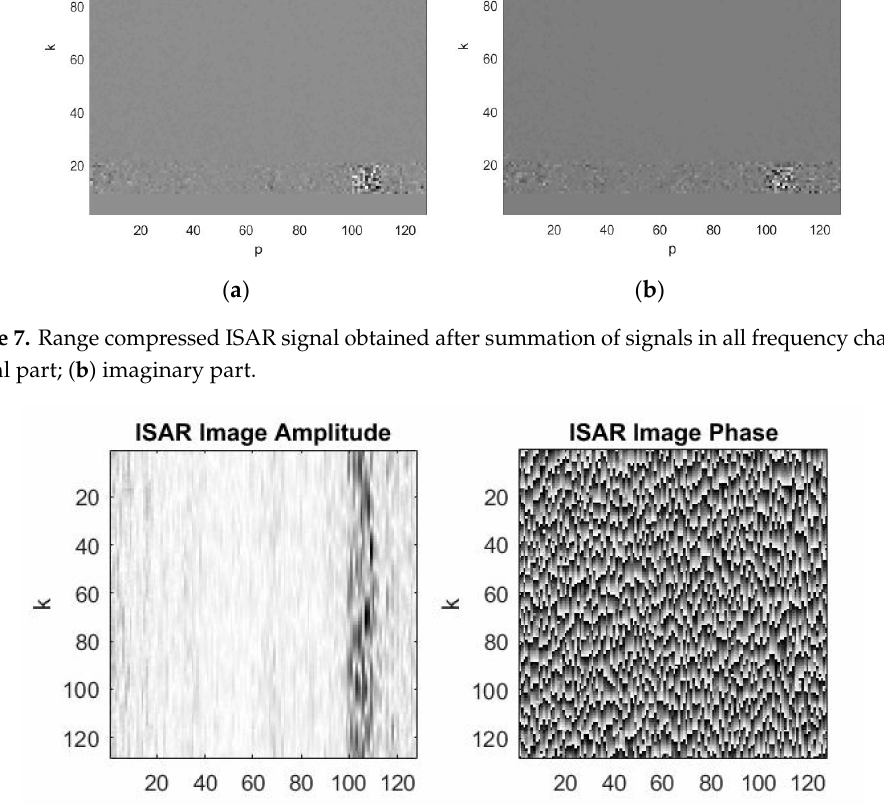
Figure 8. Complex image after azimuth compression of the range compressed ISAR signal with –15 dB signal to noise ratio: ( a ) ISAR image amplitude; ( b ) ISAR image phase.